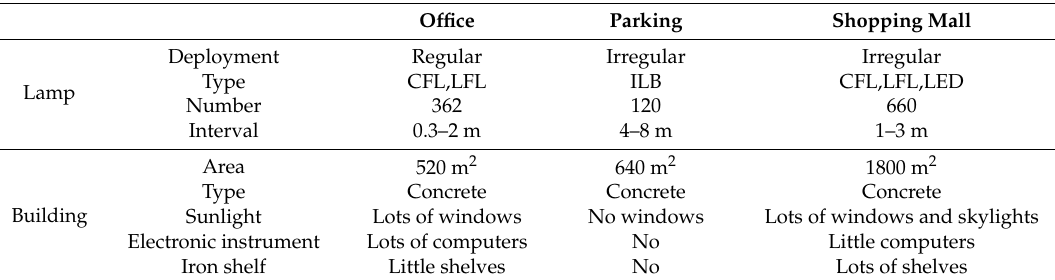
Table 1. Three typical scenario